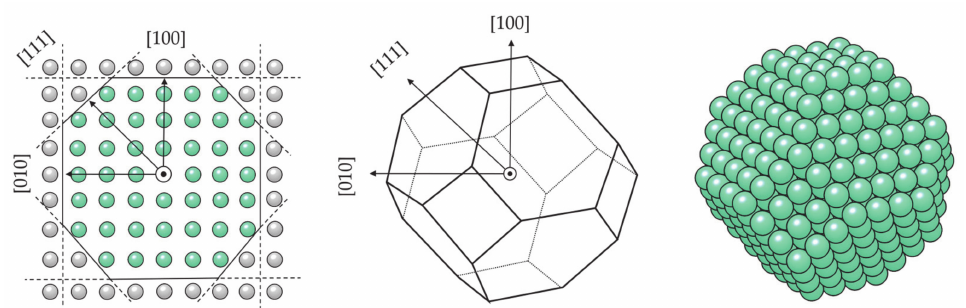
Figure 10. Illustration of the Wulff construction of an fcc particle. Growth direction of crystal facet planes is represented by black arrows, and the centre of the particle is represented by a black dot. Atoms enclosed in the equilibrium shape of the nanoparticle are coloured in teal, while the rest of the bulk atoms are grey. 3D morphology is shown in wire-frame and atomic